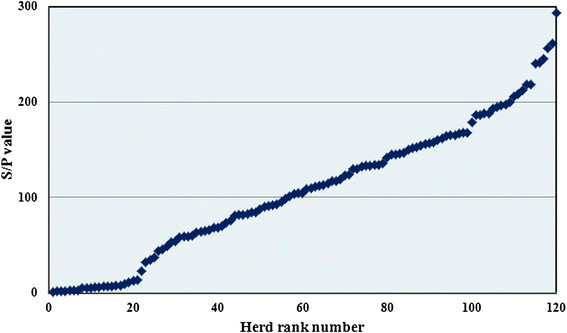
Array of antibody S/P values to
Coxiella burnetii
in bulk tank milk samples from 120 randomly selected Danish Dairy herds in July 2012.